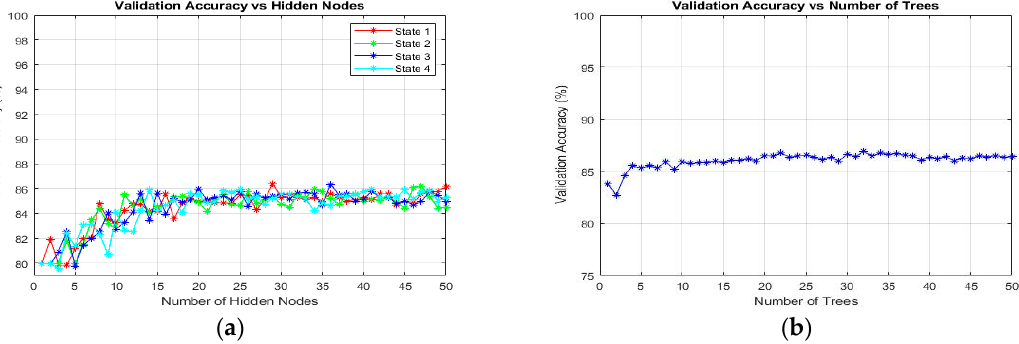
Figure 10. Analysis for classification between malaria and non-malaria parasites: ( a ) OS-ELM; ( b ) Random forest.